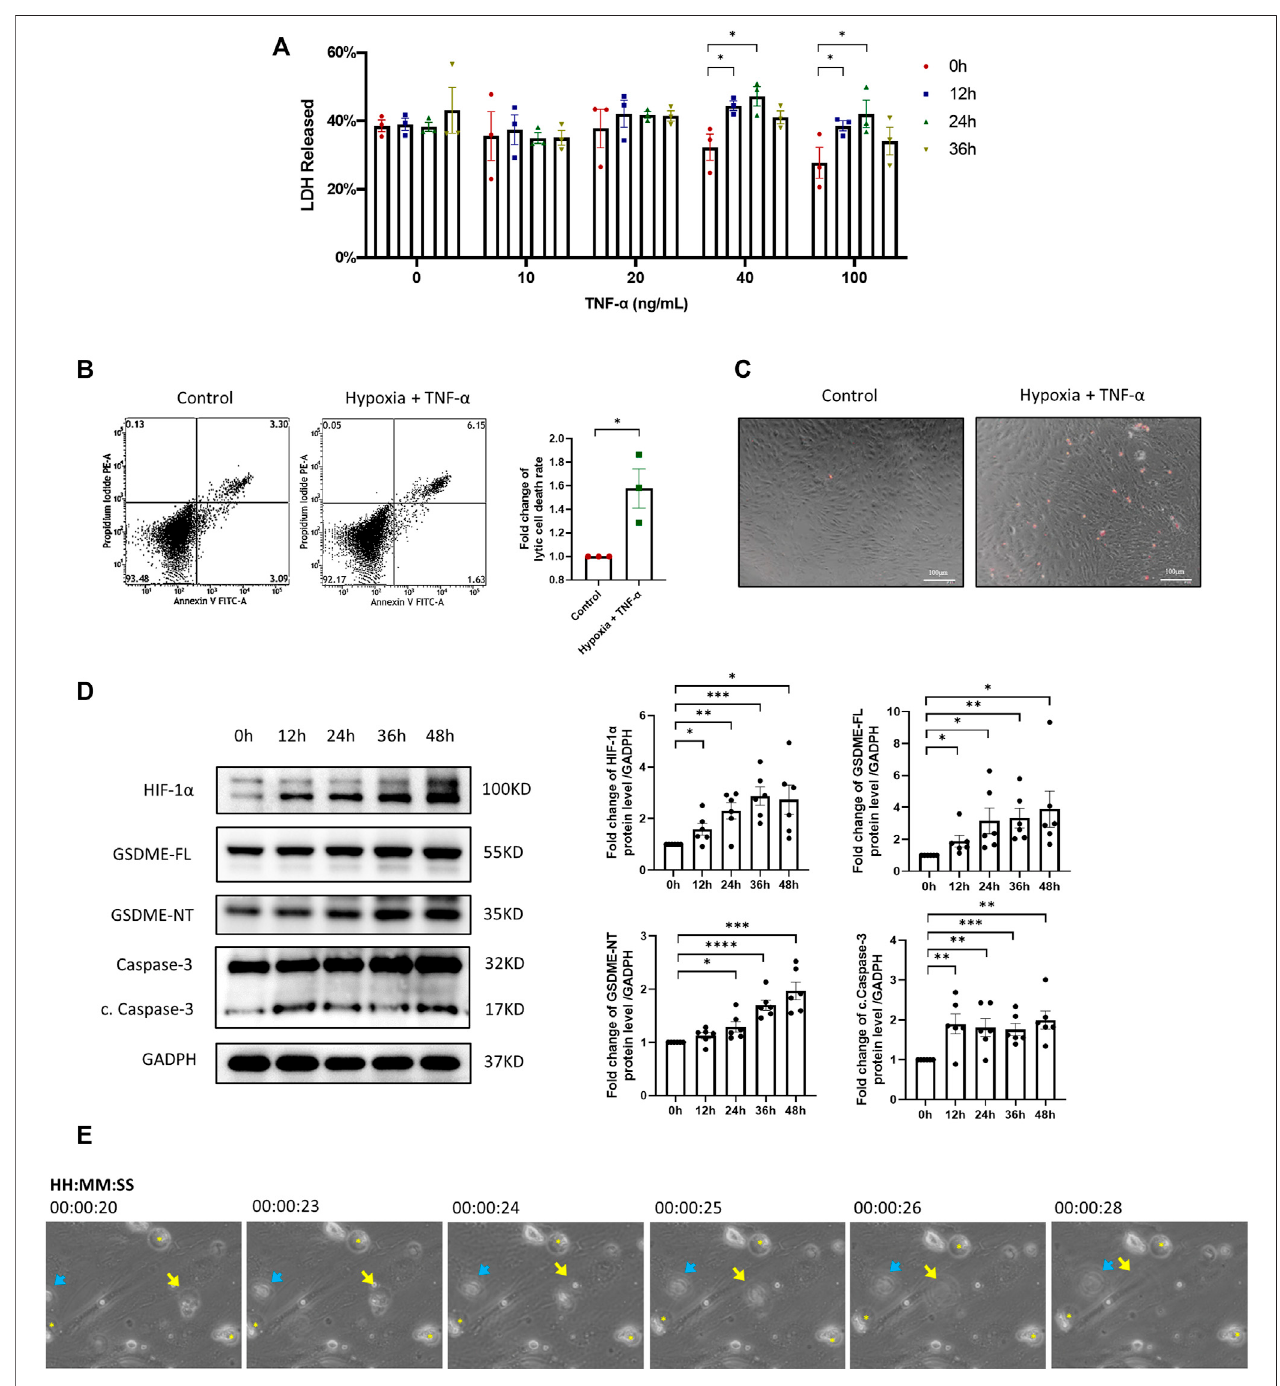
FIGURE 2 | In fl ammatory and hypoxic microenvironment triggers GSDME-mediated RA-FLSs pyroptosis. (A) LDH released by RA-FLSs treated with indicated concentrations of TNF- α under hypoxia conditions for 0-36 h ( n = 3). (B) Flow cytometry analysis ( n = 3) of Propidium Iodide (PI) and Annexin V stained cells with or withoutTNF- α +Hypoxiatreatment(40 ng/ml,36 h). (C) Representativephase-contrastimageswithPIstainingbydifferenttreatment(scalebar=100 μ m). (D) Western blotanalysisofcaspase-3,cleavedcaspase-3,GSDMEandN-terminalcleavageofRA-FLSstreatedwith40 ng/mlTNF- α underhypoxiaconditionsfor0-48 h( n = 6).HIF-1 α servesasamarkerofeffectivehypoxicstimulus,GADPHservesasaloadingcontrol. (E) VideocapturesofRA-FLSsunderTNF- α +Hypoxiatreatment(40 ng/ ml, 36 h). Blue arrow and yellow arrow point out two bursting cells. Yellow asterisks designate the swelling cells. Data are shown as mean ± s.e.m and results are representative of three independent experiments. * p < 0.05, ** p < 0.01, *** p < 0.001, **** p < 0.0001 using one-way ANOVA.